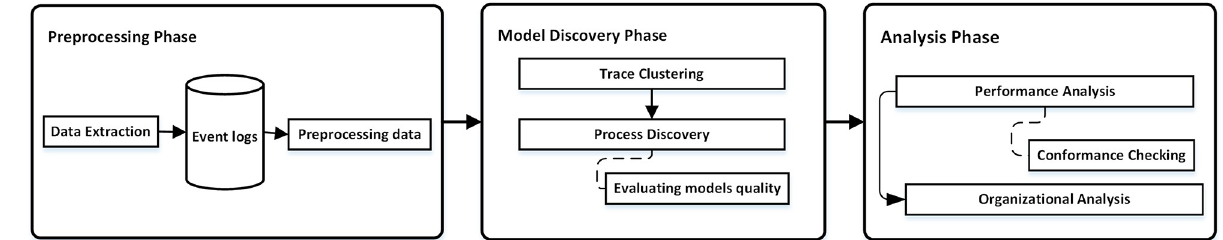
Fig 2. Proposed methodology based on process mining for patient’s careflows.